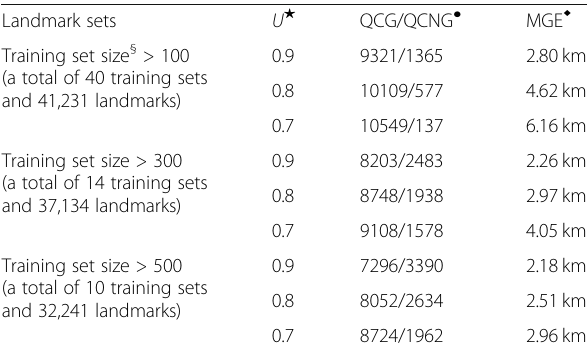
Table 3 Relationship between different training set sizes, different thresholds and the quantity of the entities that can